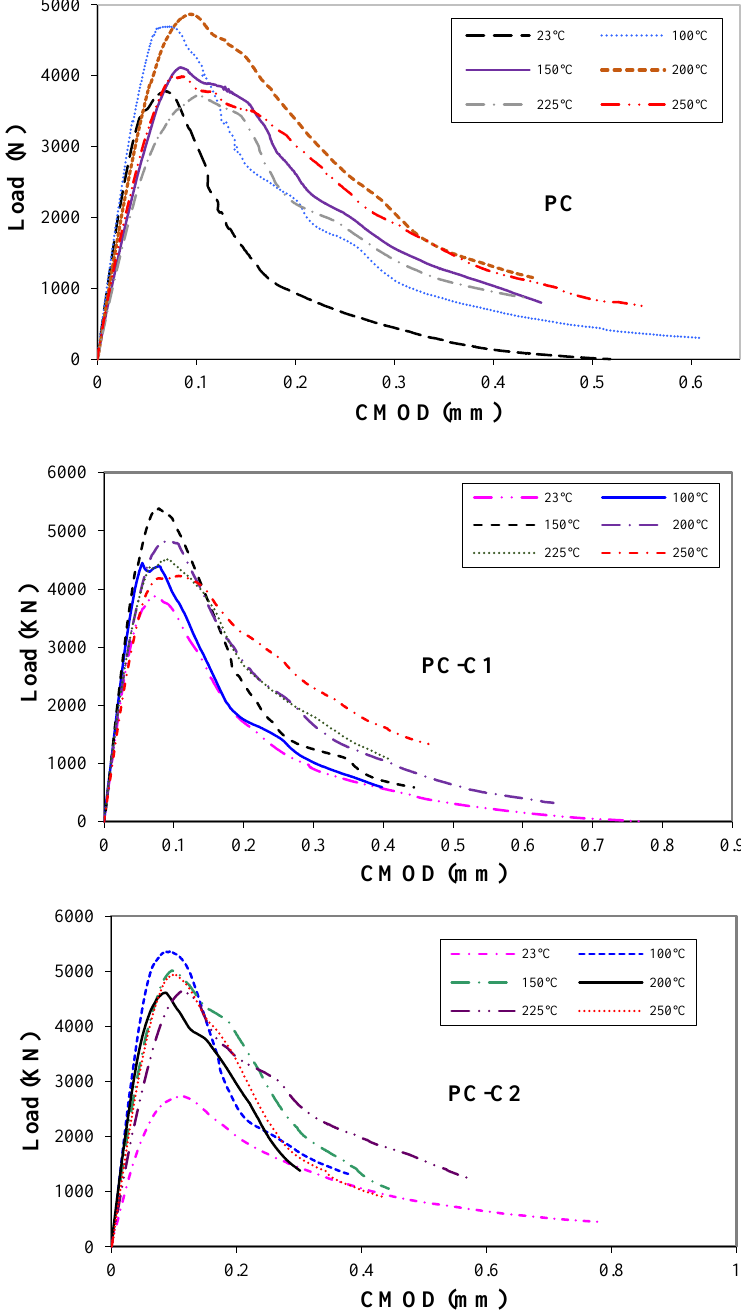
Figure 11. Load – CMOD for PC systems for different heating temperatures. Figure 11. Load–CMOD for PC systems for different heating